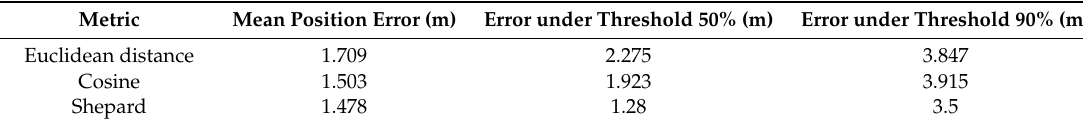
Table 5. Comparison of positioning performance using different similarities.